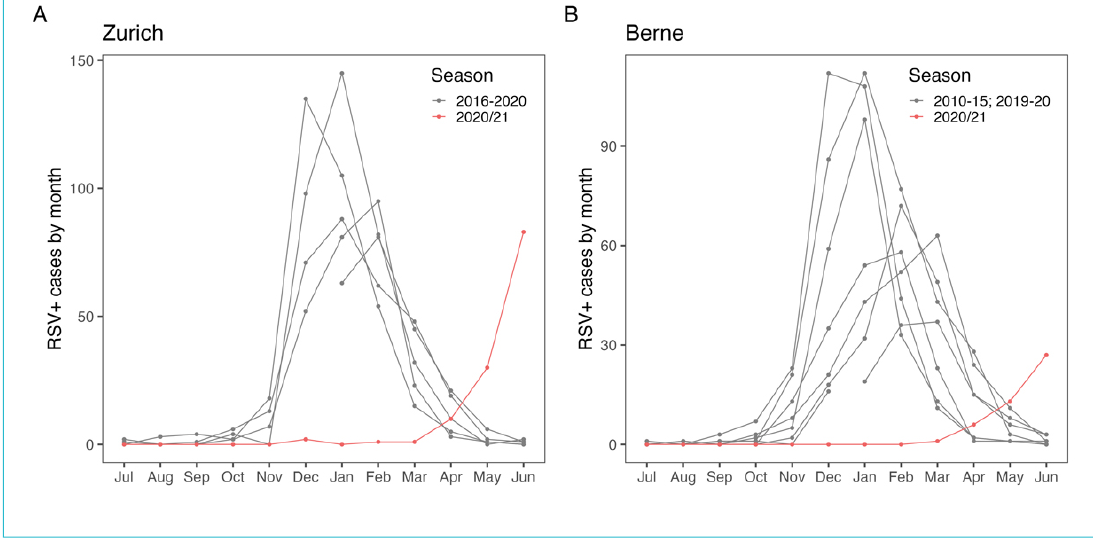
Figure 1: Comparison of RSV case numbers before and during COVID-19 pandemic in (A) Zurich and (B) Berne.